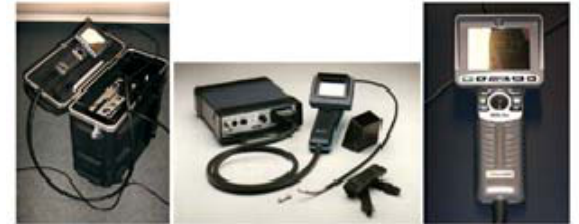
Figure 11. PXL Series - XL PRO Base System of Benecon S.C.aR.L